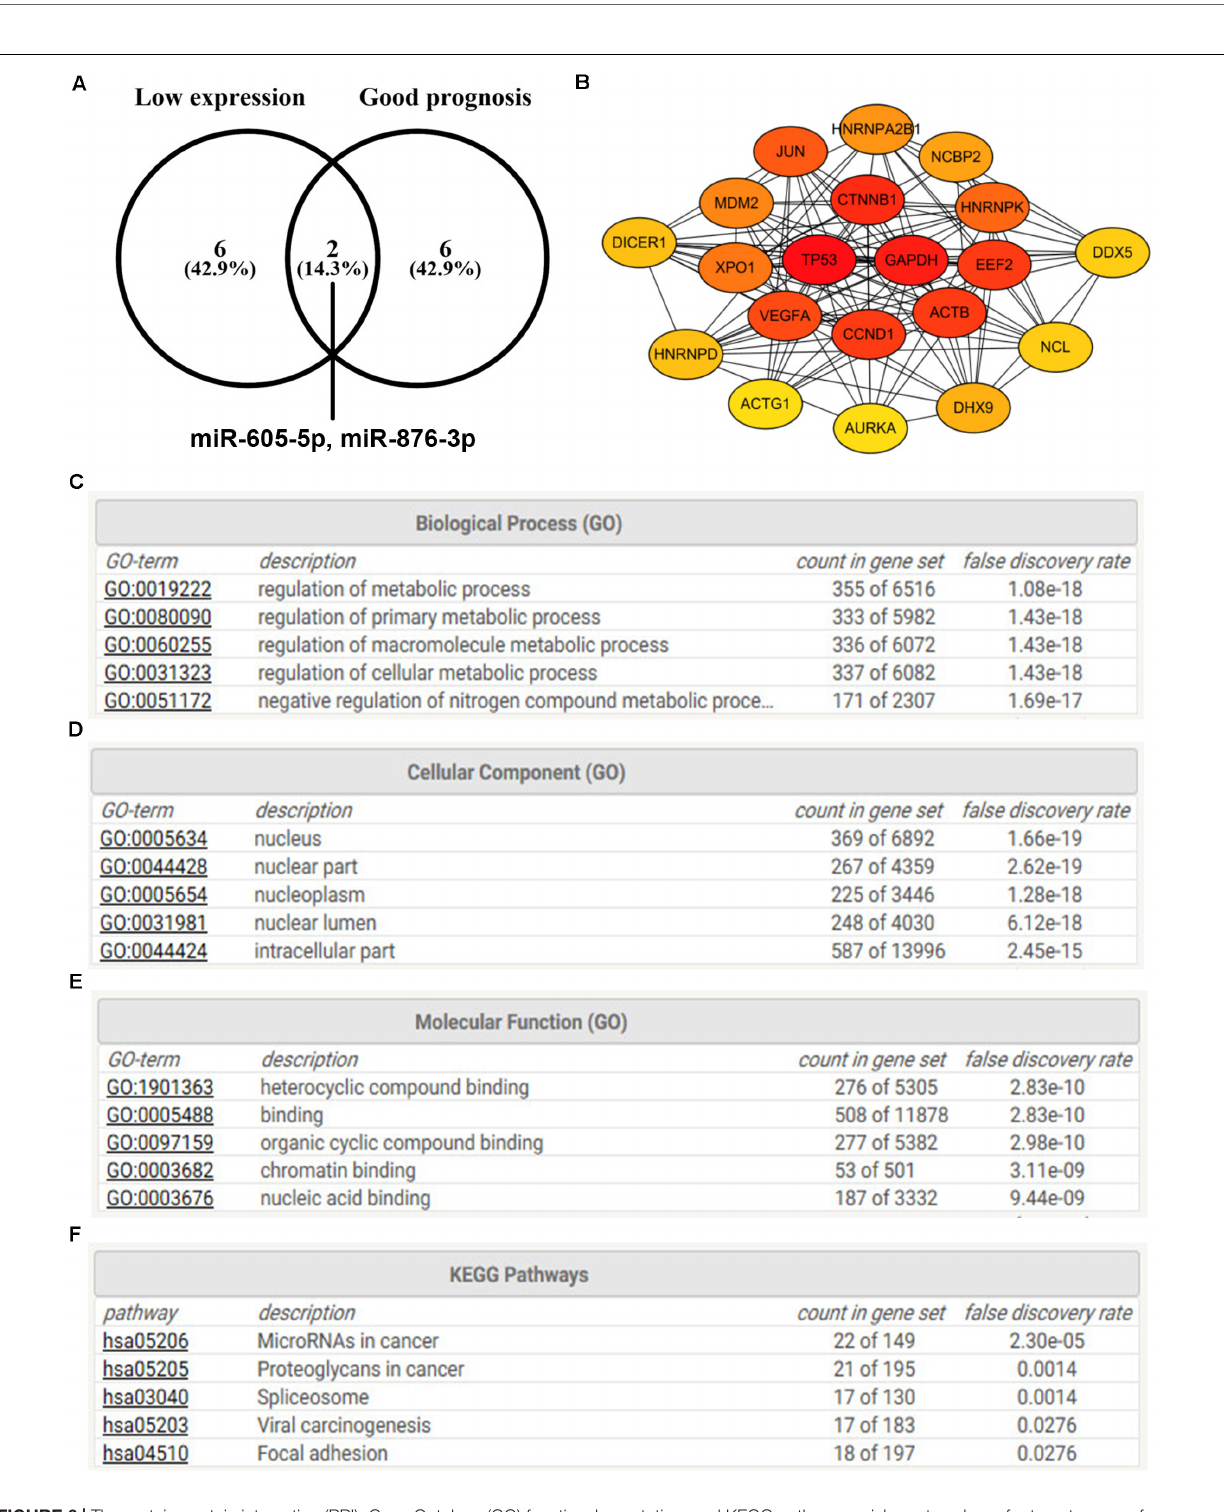
Frontiers in Cell and Developmental Biology |